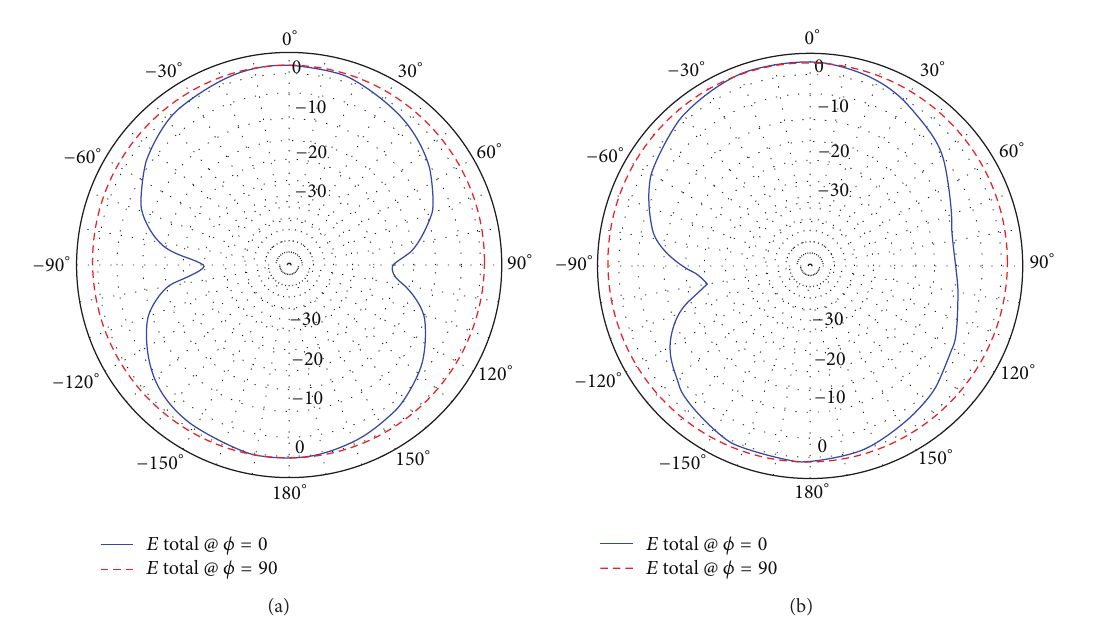
Figure 5: Radiation patterns of (a) the low band antenna at 900MHz and (b) the high band antenna at 2.3 GHz.